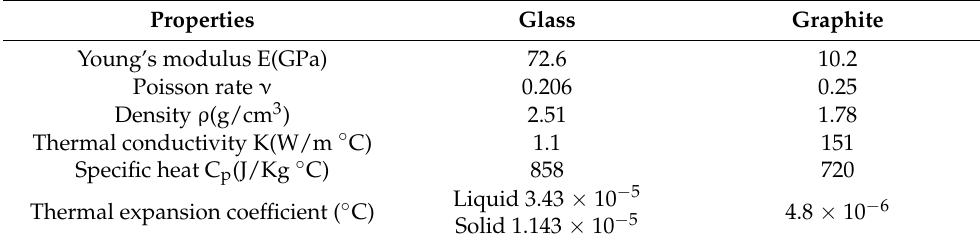
Table 1. Mechanical Properties of glass and graphite.